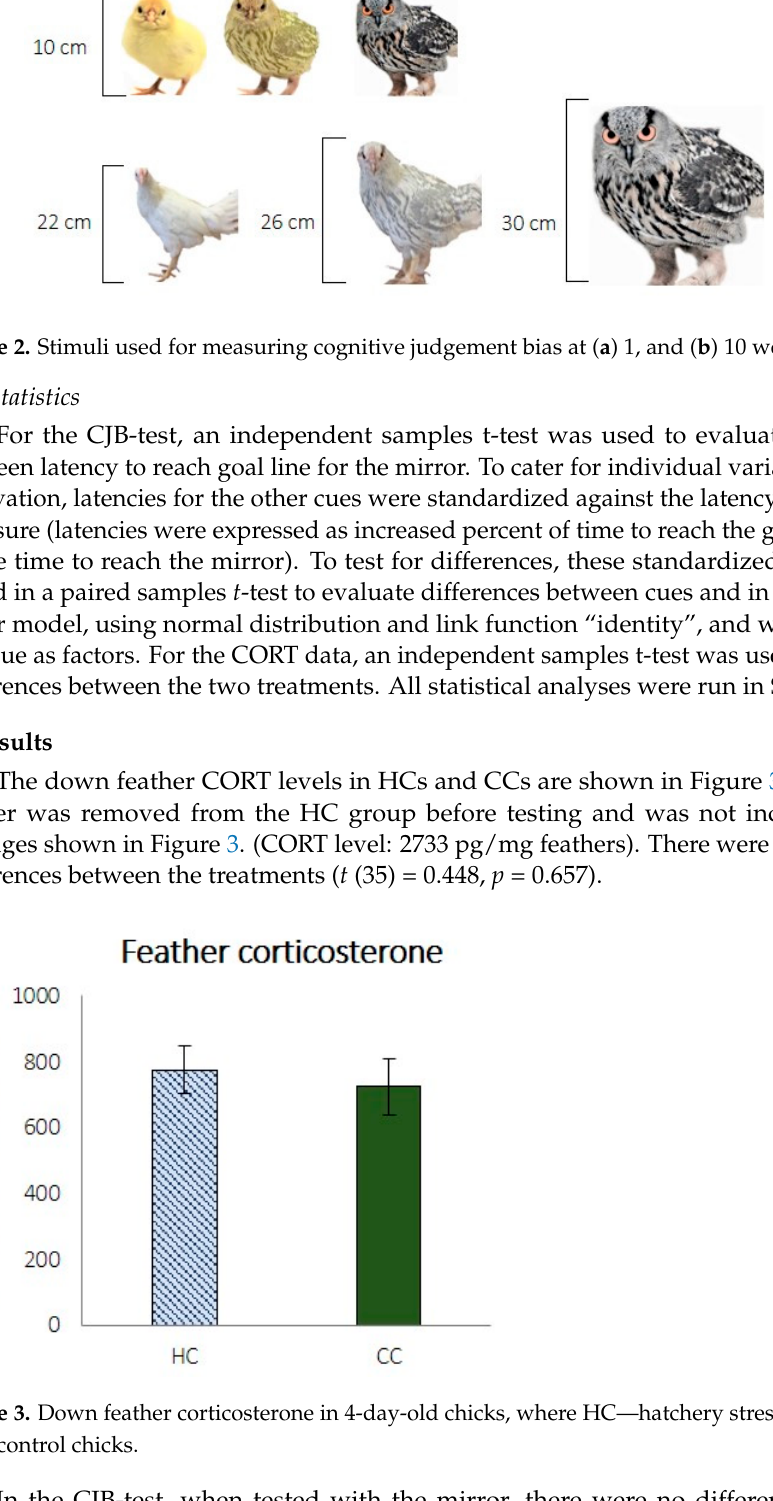
Figure 2. Stimuli used for measuring cognitive judgement bias at ( a ) 1, and ( b ) 10 weeks of age.